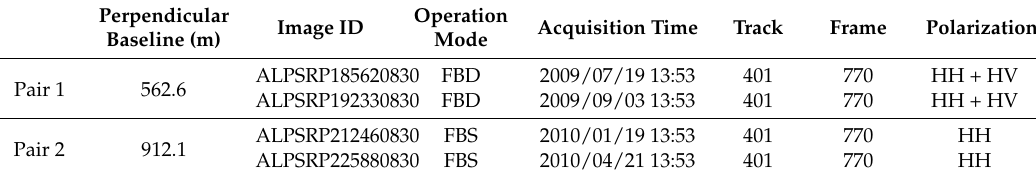
Table 1. ALOS PALSAR images used for two pass DInSAR processing over the target area.